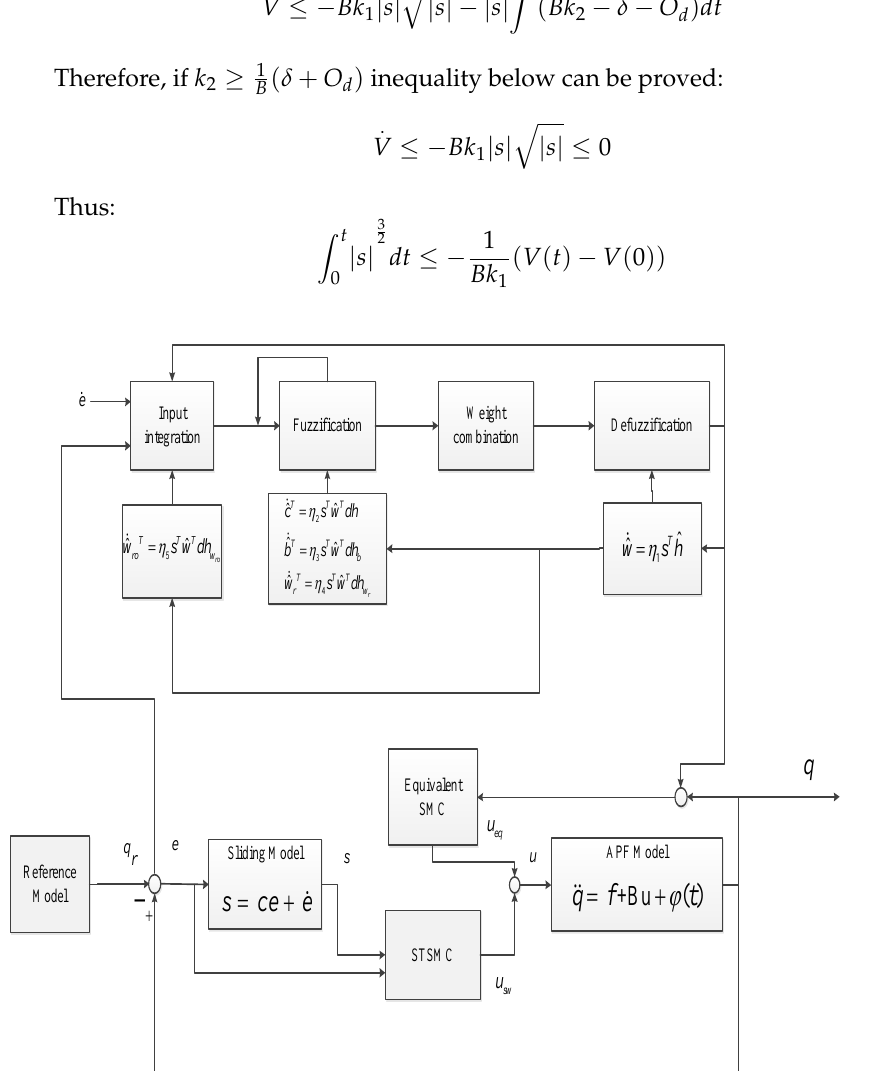
Figure 3. Block diagram of STSMC-OFFNN controller.